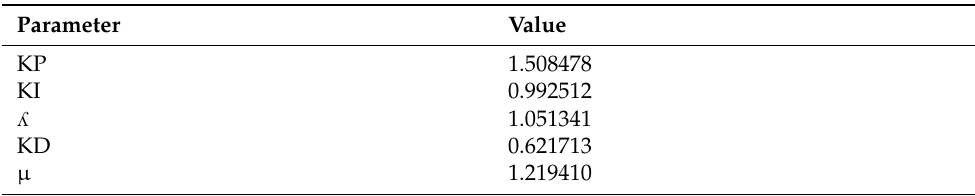
Table 13. Optimized FOPID parameters.